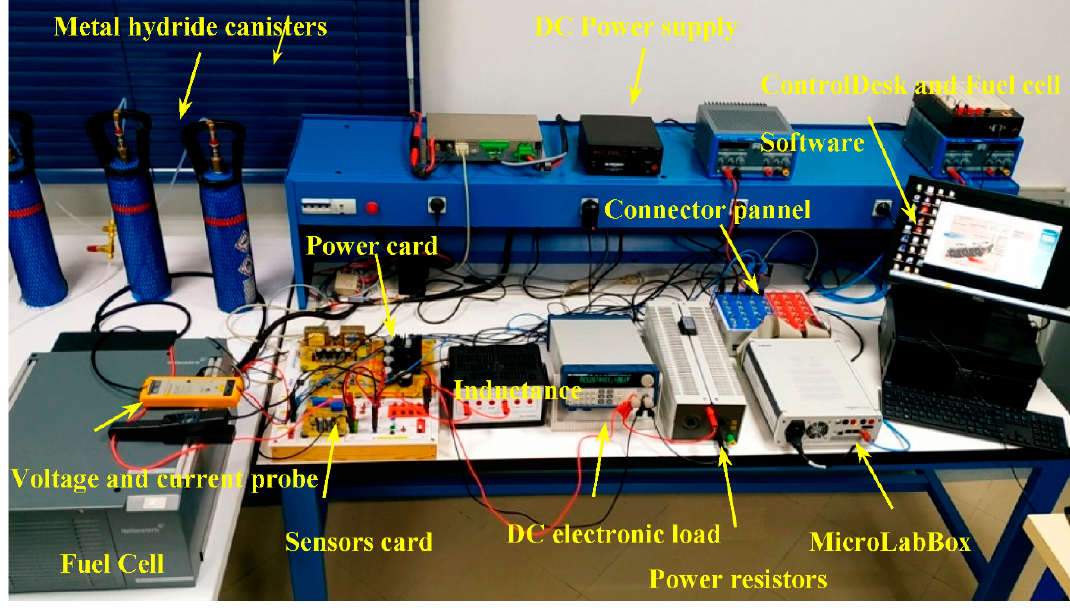
Figure 21. Laboratory prototype used for experimental validation. Table 5. Control design parameters.